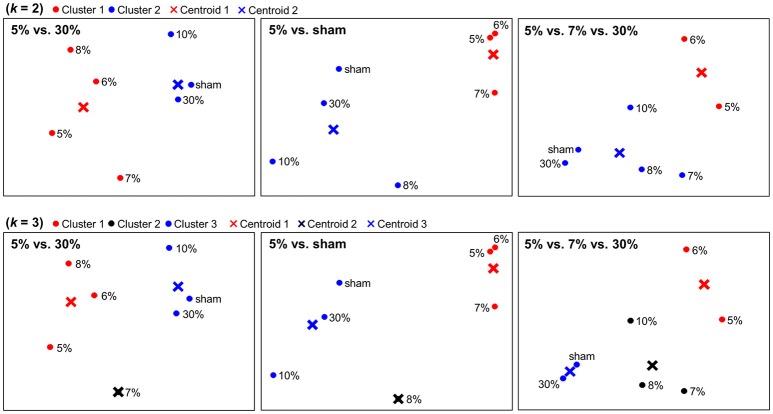
Spatial depictions of the neural representation of stickiness intensities. Using a principal component analysis (PCA), neural representations of stickiness intensities were mapped into a 2-dimensional space. A follow-up k-means clustering analysis revealed how the neural activity patterns of stickiness intensities were categorized together. The centroids of each group were marked in “×”. First row: Spatial configurations for neural categorizations in response to 7 stickiness intensities, when k = 2. Second row: Spatial configurations for neural categorizations in response to 7 stickiness intensities, when k = 3. Regarding associated brain regions, the first column was based on the significant clusters in postcentral gyrus and thalamus. The second column was based on the eight significant clusters including bilateral PPC, MTG, insula, SMA, thalamus, ITG, and ACC. The last column was based on the significant clusters in putamen.